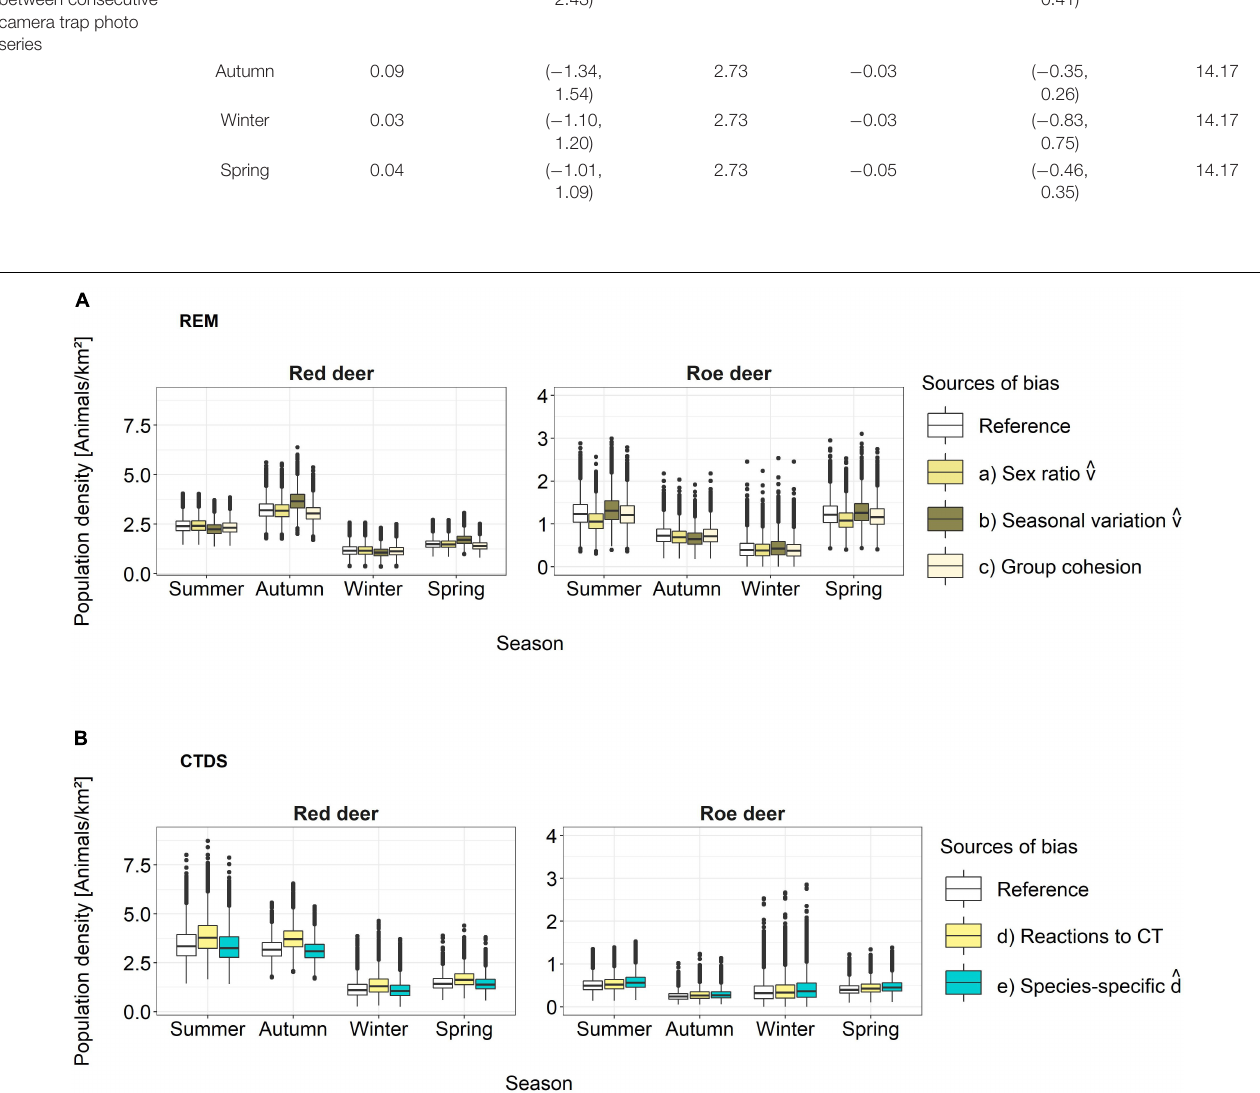
FIGURE 5 | The influence of biased model parameters on population density estimates of REM and CTDS. These include (A) for REM, (a) the assumption of a balanced sex ratio, (b) the use of year-round GPS telemetry data to estimate movement speed and (c) the use of the first photo per series only for group size estimation, and (B) for CTDS, (d) the inclusion of photos regardless of behavioral reactions to camera traps and (e) the use of a non-species-specific mean delay between photo series ˆ d .